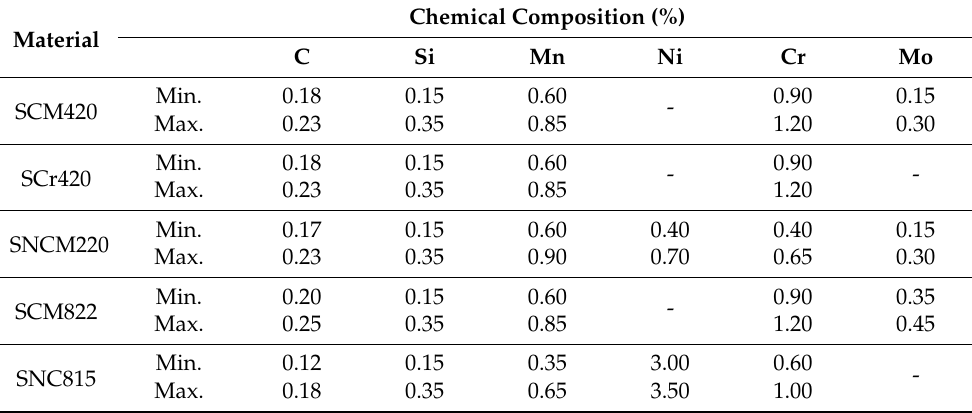
Table 3. Chemical composition of the gear materials used in this study.